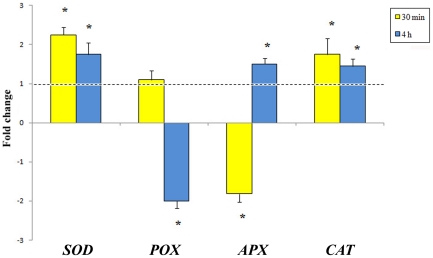
Time-course quantitative gene expression of some ROS scavenging genes in G. biloba upon herbivory.Gene expression of superoxide dismutase (SOD) and catalase (CAT) was up-regulated by herbivory at all times. Upon herbivory, peroxidase (POX) was significantly down-regulated after 4 h, whereas ascorbate peroxidase (APX) was down-regualted after 30 min. The dotted lines represent control values (mechanical damage), different letters indicate significant (P<0.05) differences, asterisk indicates significant (P<0.05) differences with respect to control.